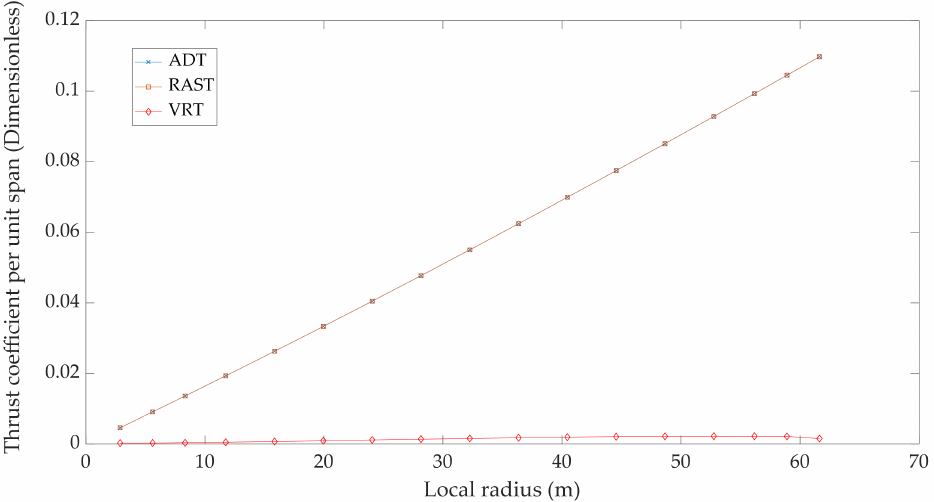
Figure 8. Thrust coefficient per unit span as a function of the local